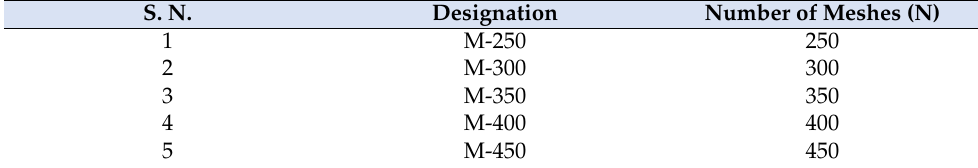
Table 3. Detailed specifications of meshed ventilation cloths with thickness of 8 × 10 − 5 m. S. N. Designation Number of Meshes (N) 1